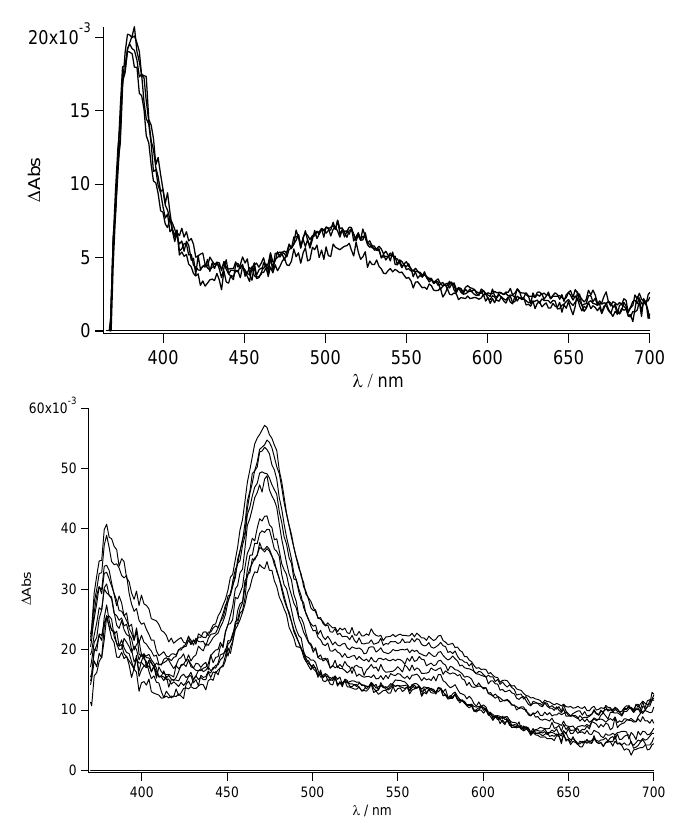
Figure 12. Top: Sub-nanosecond transient absorption spectra of TpyPhPyrene = 340 nm and 200 ps incremental time delay, Bottom: Sub-nanosecond transient with  ex absorption spectrum of TpyPhPyrene incremental time